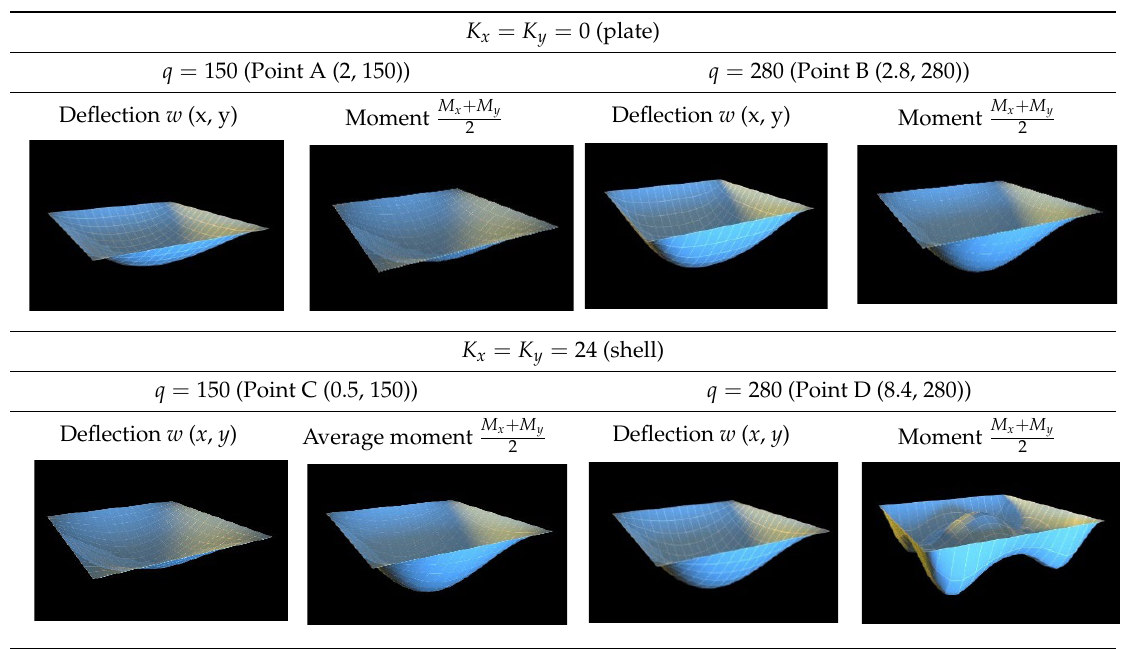
Table 1. Surfaces of deflection and stress of the plate and the